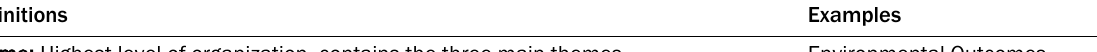
Table 1. Outcome Organization Structure with Definitions and Examples